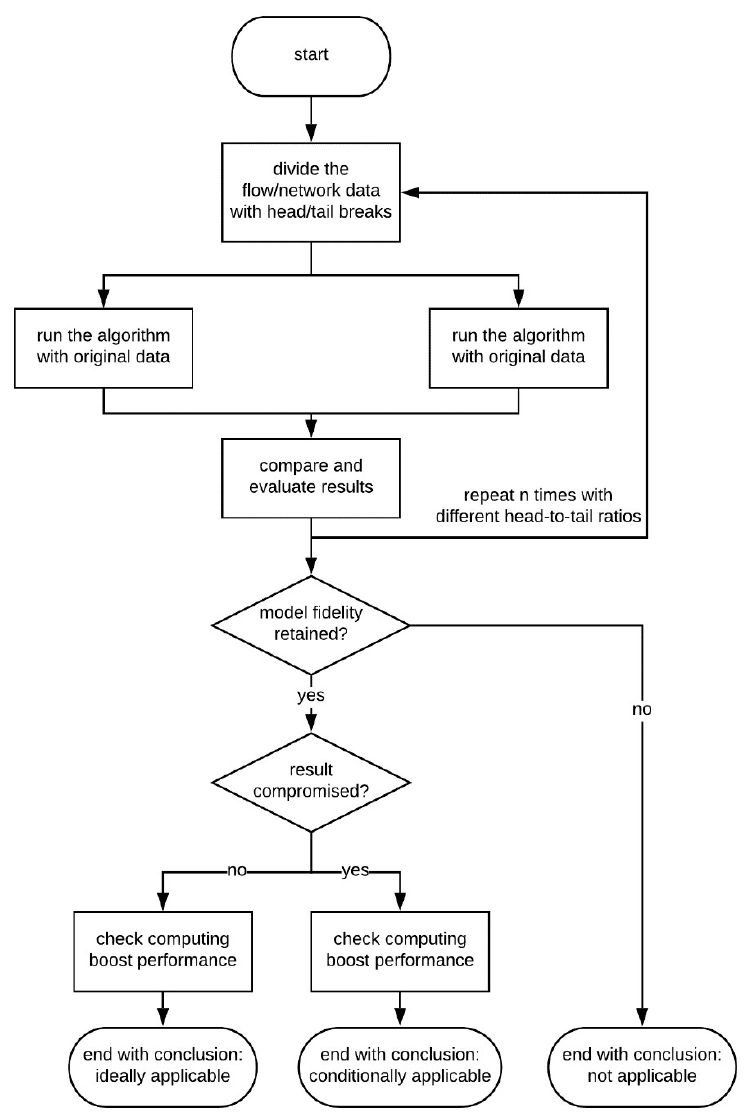
Figure 2. Evaluation framework flowchart.